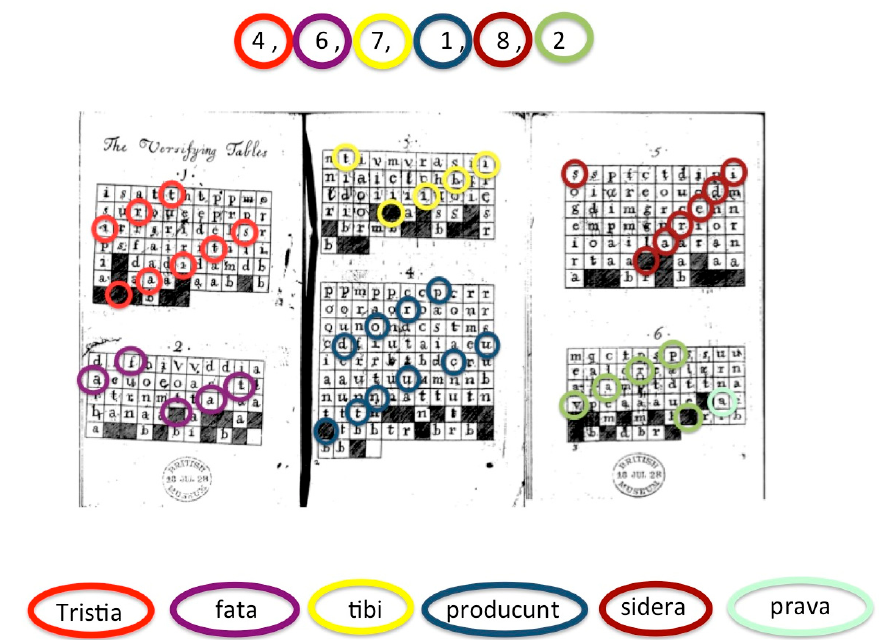
Figure 7. The resulting Latin verse line based on the application of the six digits 4, 6, 7, 1, 8, 2 ( Artificial Versifying , John Sims, 1677).